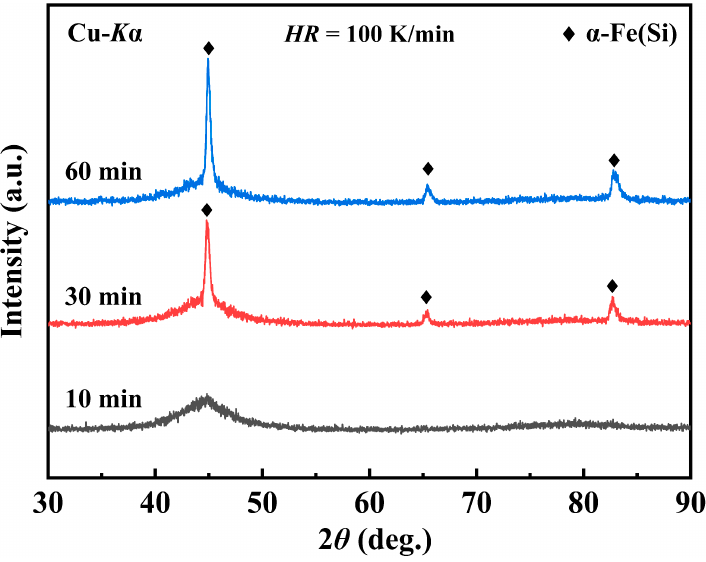
Figure 7. XRD patterns of Fe 74.75 Si 8 B 10 P 3 C 2 Nb 1.5 Cu 0.75 NPCs annealed for different HT .